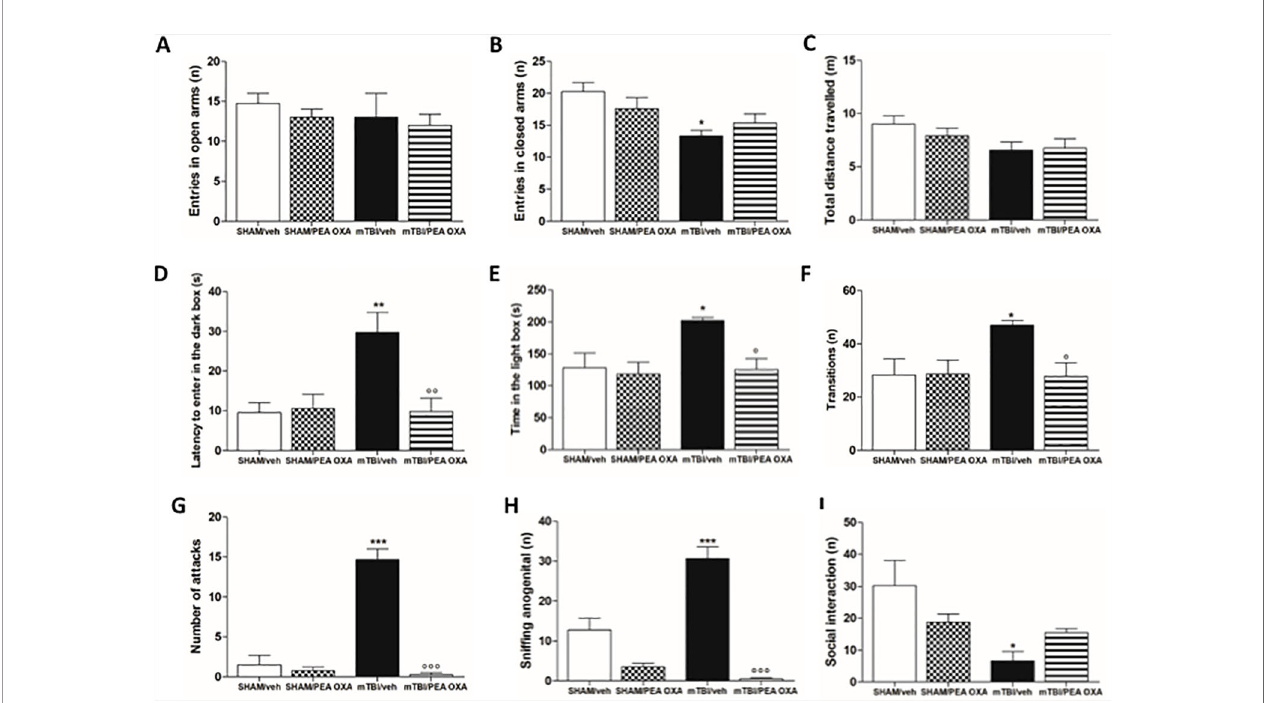
FIGURE 3 | Effects of repeated administration of vehicle (Kolliphor 5%) or PEA-OXA (10 mg/kg, i.p.) on behavioral evaluations in sham and mTBI mice. (A – C) Entries in open arms, entries in closed arms and total distance travelled, respectively in elevated plus maze, (D – F) latency to enter in the dark box, time in the light box and transition, respectively, in light-dark box test, (G – I) number of attacks, snif fi ng ano-genital and social interaction, respectively, in resident intruder test. Data are represented as mean ± SEM of six to eight mice per group. *P < 0.05, **P < 0.01 and ***P < 0.001 indicate signi fi cant differences compared to SHAM/veh. °P < 0.05, °°P < 0.01, and °°°P < 0.001 indicate signi fi cant differences compared to TBI/veh. P < 0.05 was considered statistically signi fi cant. One-way ANOVA, followed by Bonferroni post hoc test was